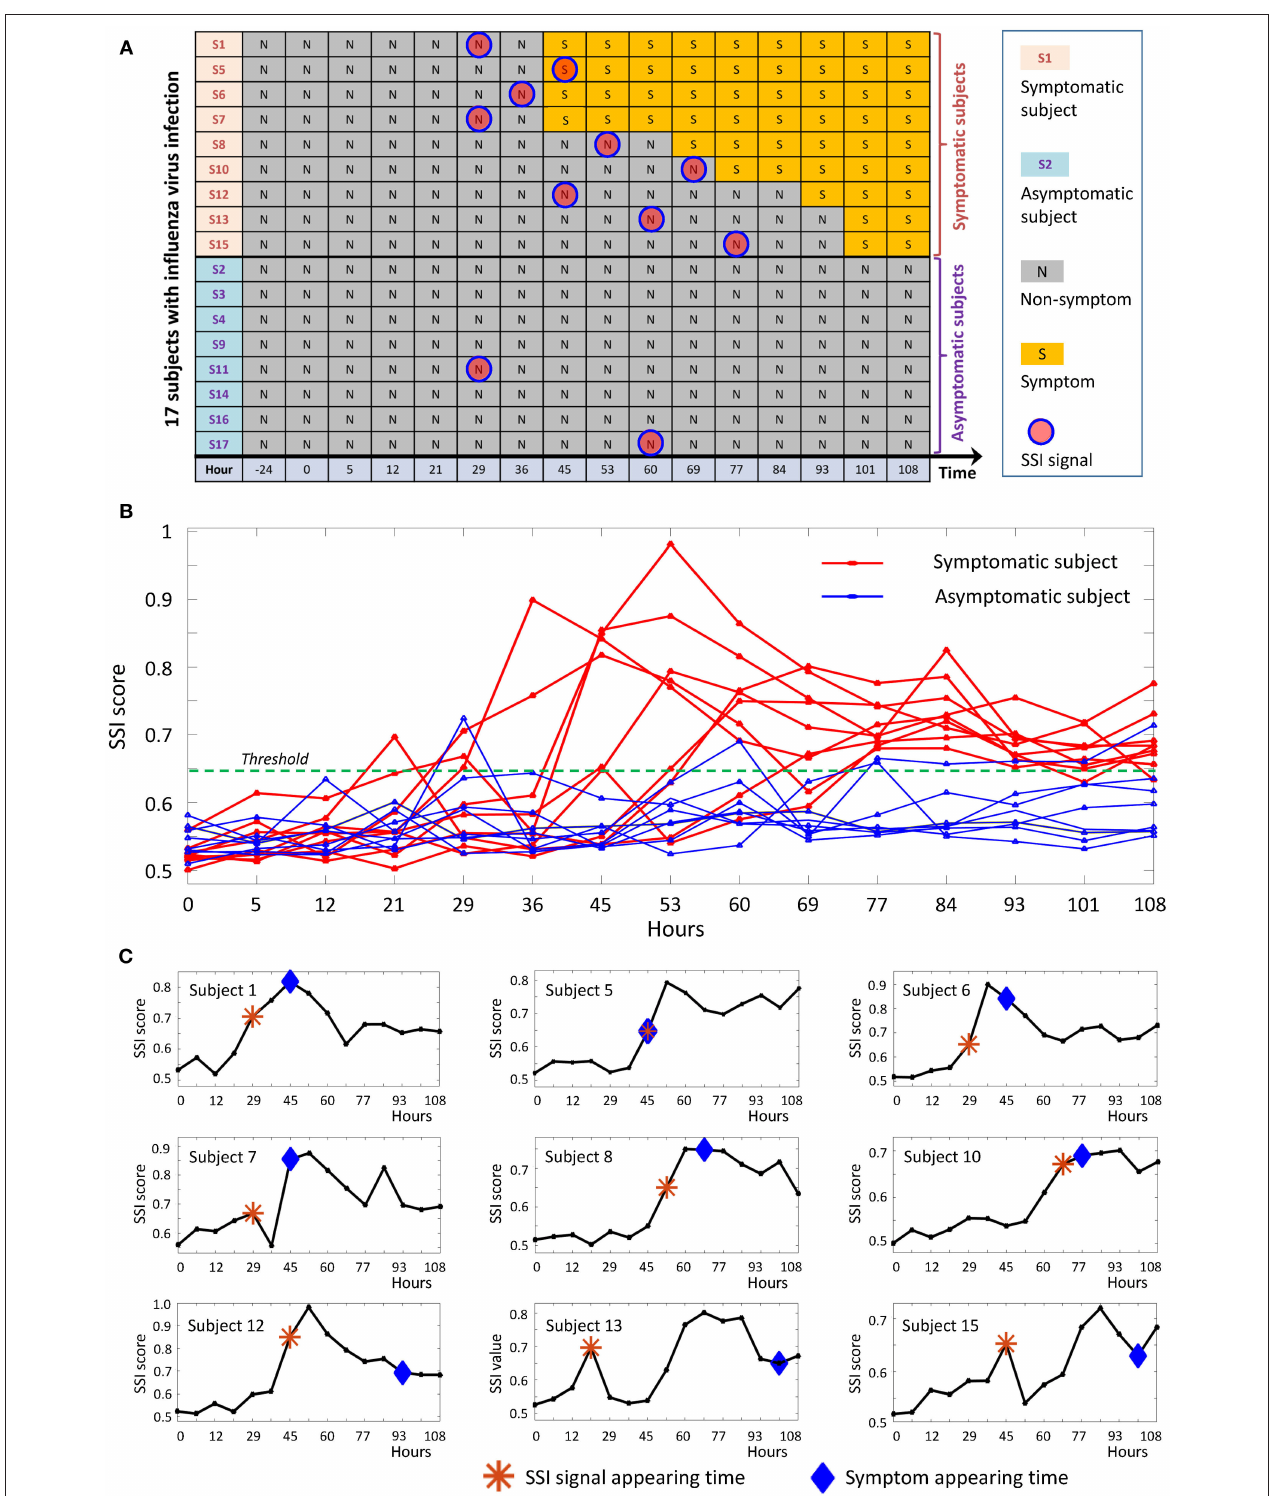
FIGURE 5 | The application of SSI score in influenza infection dataset. (A) The overall information of the 17 subjects in the influenza-infection challenge. (B) Line chart of SSI score for all 17 subjects. The red curves are for symptomatic subjects, while the blue curves represent asymptomatic subjects. (C) The individual-specific SSI scores for 9 symptomatic subjects. For each SSI curve, the star symbol represents the time point when SSI-score signal arises, the diamond symbol represents the time point at which the initial flu symptoms appears.